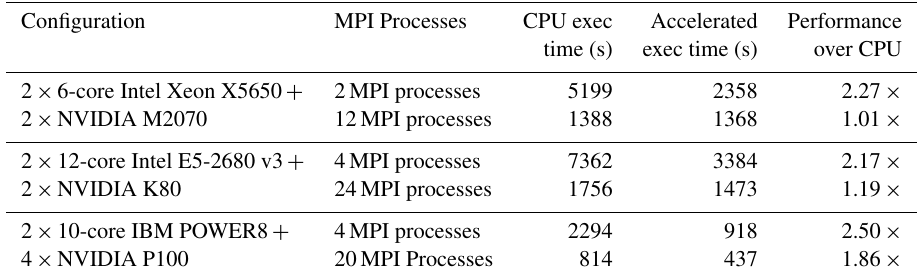
Table 4. Application execution time and achieved speed-up of the three node configurations for 24h simulated time.